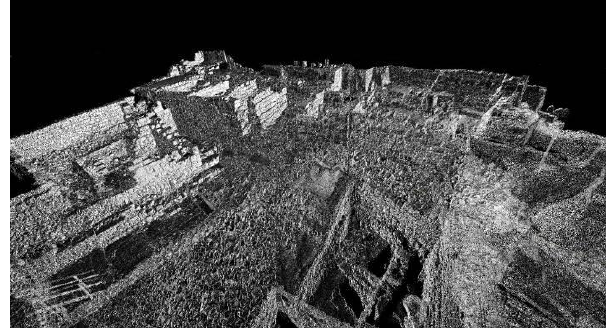
Figure 2: 3D model of Givati Parking Lot Excavation